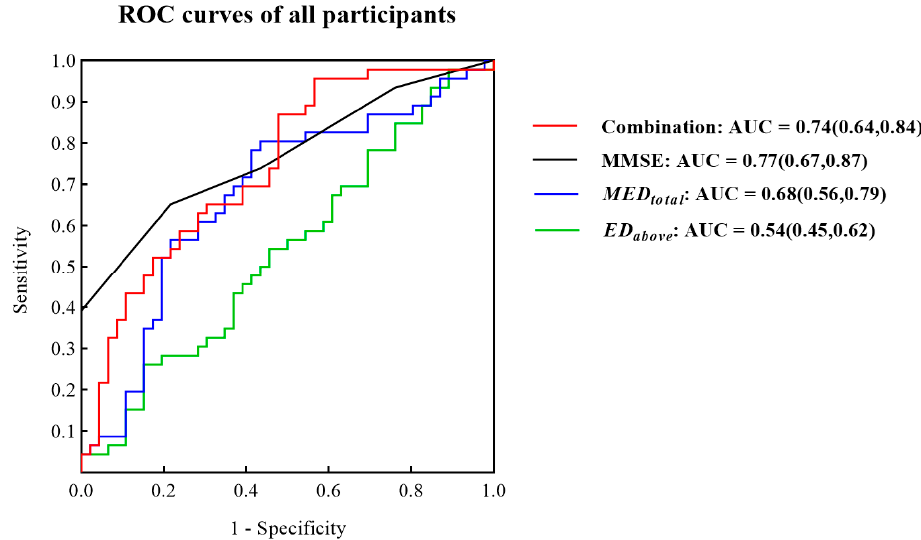
Figure 5. ROC curves of MMSE, 𝑀𝐸𝐷 (cid:3047)(cid:3042)(cid:3047)(cid:3028)(cid:3039) , 𝐸𝐷 (cid:3028)(cid:3029)(cid:3042)(cid:3049)(cid:3032) and the combination of 𝑀𝐸𝐷 (cid:3047)(cid:3042)(cid:3047)(cid:3028)(cid:3039) and 𝐸𝐷 (cid:3028)(cid:3029)(cid:3042)(cid:3049)(cid:3032) Figure 5. ROC curves of MMSE, MED total , ED above and the combination of MED total and ED above for for the NC and MCI groups. the NC and MCI groups.